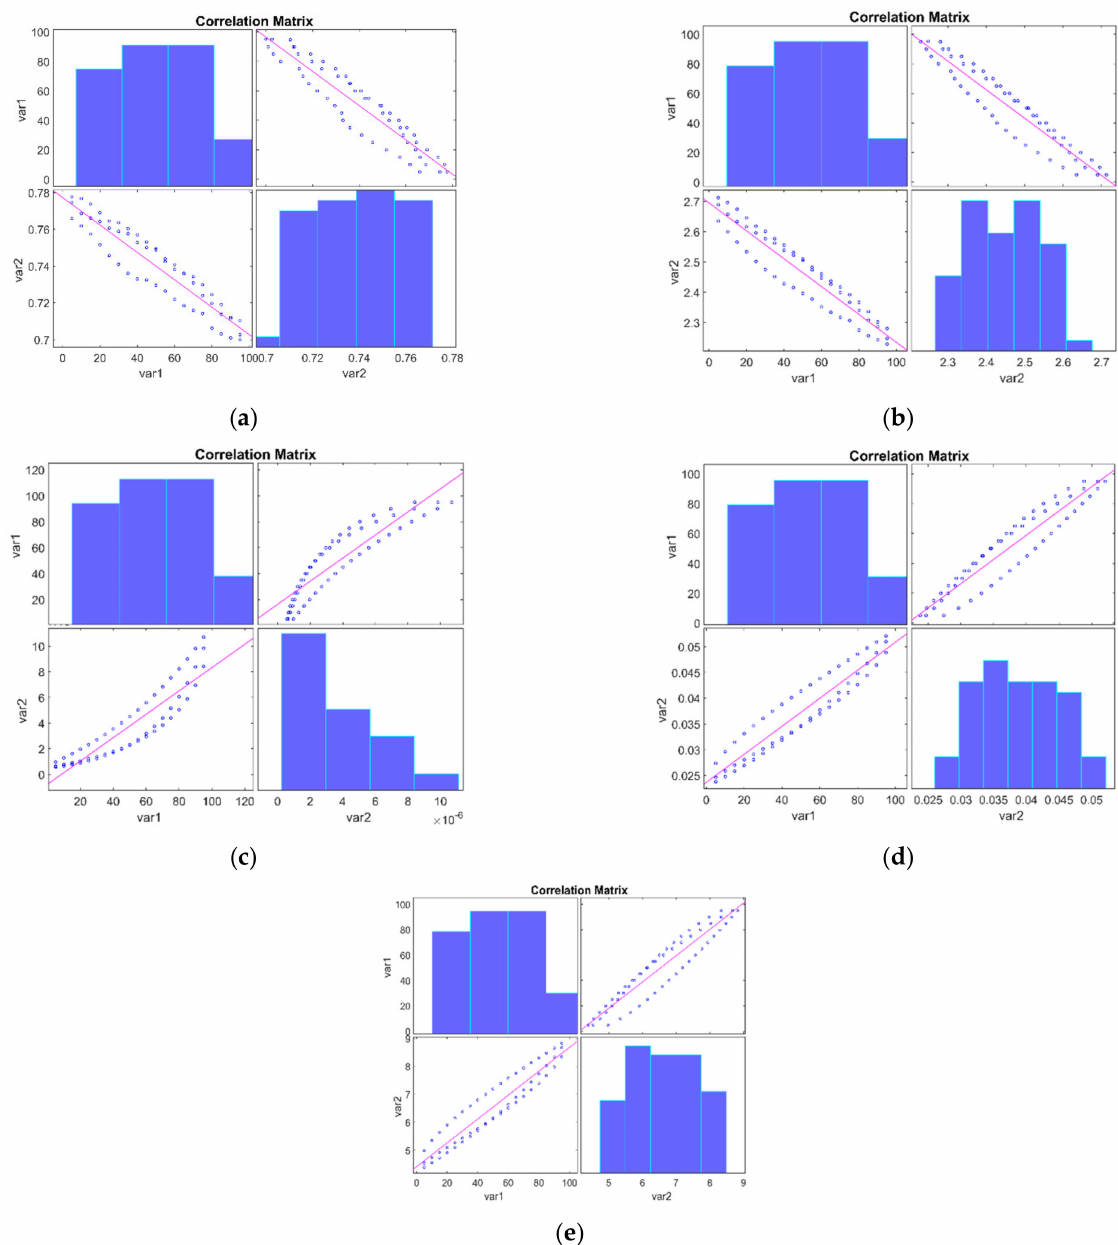
Figure 7. Correlation analysis of extracted features: ( a ) Skewness, ( b ) Kurtosis, ( c ) Variance, ( d ) SVER, and ( e )